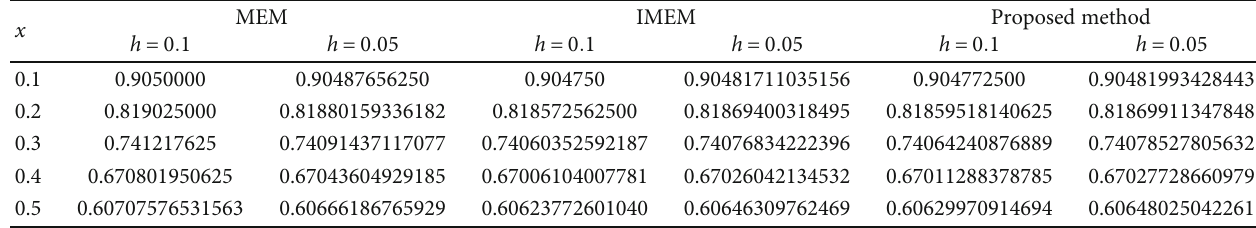
Table 5: Numerical solutions for Example